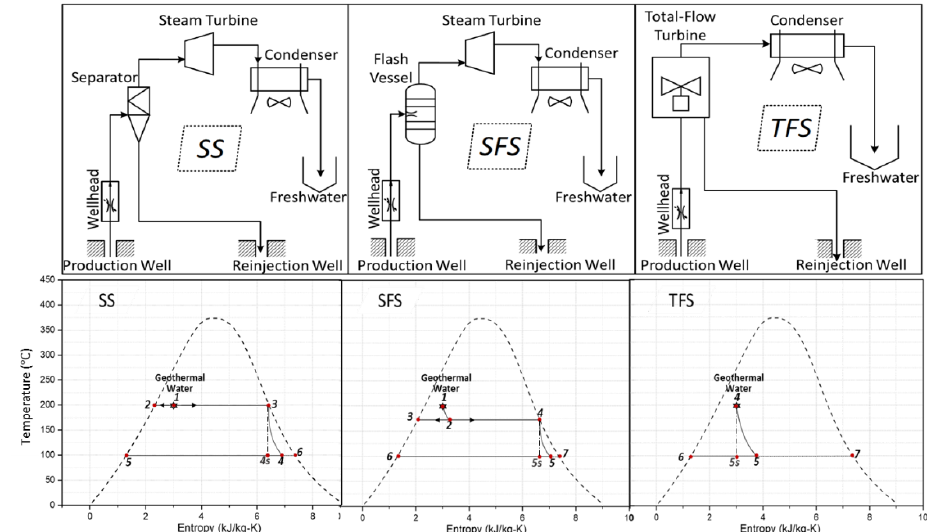
Figure 2. Configurations and temperature–entropy diagrams of the steam system (SS), single-flash system (SFS), and trilateral flash system (TFS).